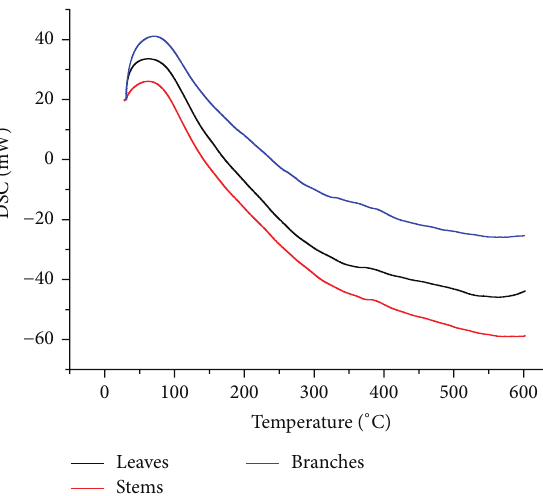
Figure 2: Derivative TGA curves for the three types of willow samples.